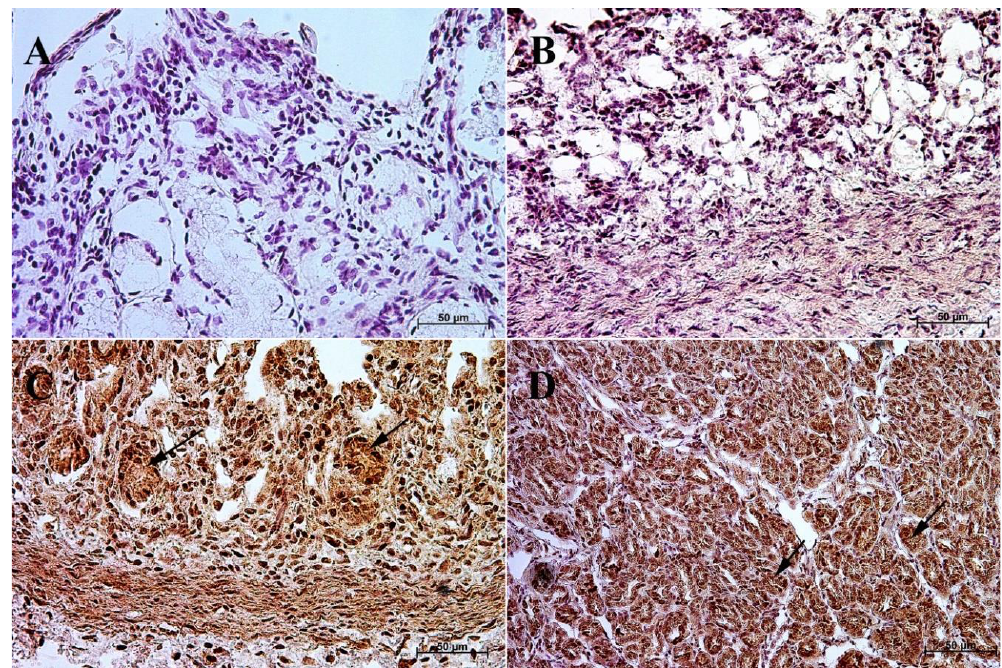
Figure 5. Immunoreactivity of anti-cholecystokinin antibody in the fundic mucosa of the stomach, 40×. ( A ) the first age group, ( B ) the second age group, ( C ) the third age group, ( D ) adult reference group. The arrow indicates positive immunohistochemical reaction.